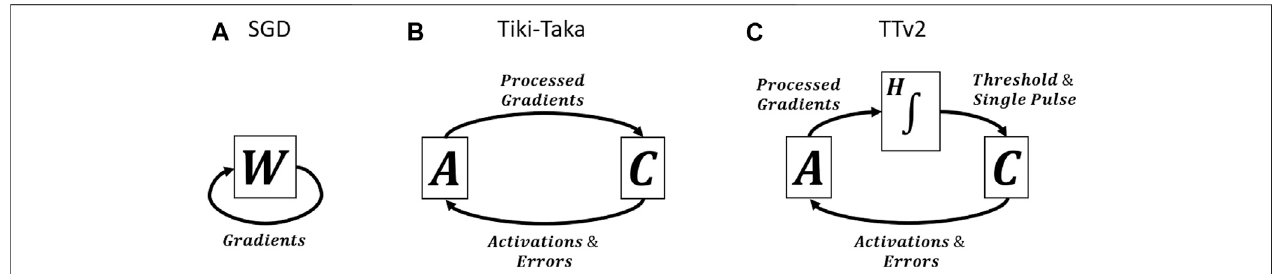
FIGURE 2 | Schematics of SGD, Tiki-Taka, and TTv2 dynamics.